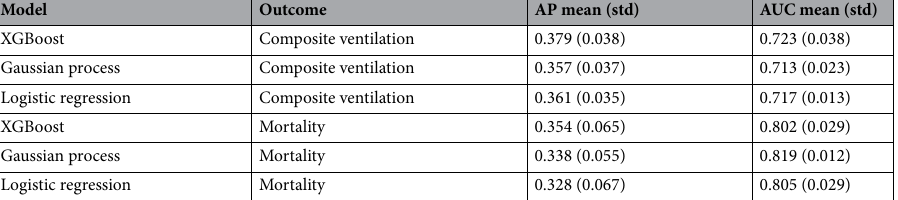
Table 4. Prediction performance using all clinical features. Adverse outcome prediction performance at the point of entry for the various ML models in terms of average precision (AP) and area under receiver operating curve (AUC).